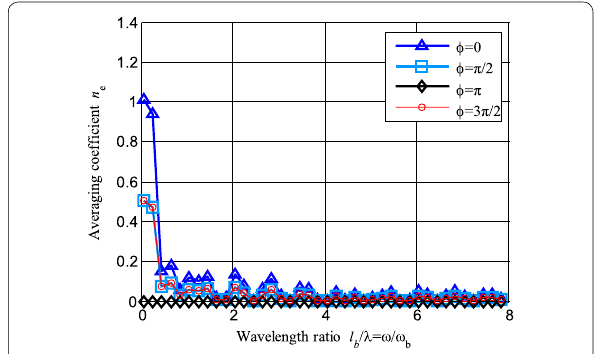
Figure 12 Averaging coefficient curves for different phases